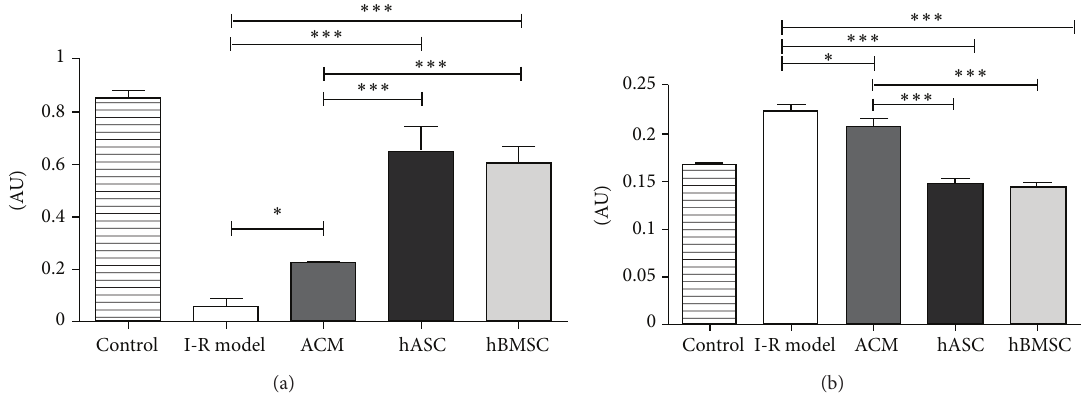
Figure 4: Metabolic activity measurement and LDH assay. (a) The metabolic activity measured 24 hours after the ischemia-reperfusion injury significantly decreased in the cells after the ischemic conditions compared to the control group, but the metabolic activity was enhanced with all the applied treatments (control: 0.858±0.021 AU; I-R model: 0.065±0.033 AU; ACM: 0.225±0.013 AU; hASC: 0.652±0.089 AU; hBMSC: 0.607±0.059 AU; 𝑛 = 3 , ∗ 𝑃 < 0.05 , ∗∗∗ 𝑃 < 0.001 ). (b) LDH levels in the cell culture supernatant were significantly lower when ACM, hASC, or hBMSC therapy was carried out (I-R model: 0.225±0.006 AU; ACM: 0.208±0.009 AU; hASC: 0.148±0.005 AU; hBMSC: 0.146±0.004 AU; 𝑛 = 3 , ∗ 𝑃 < 0.05 , ∗∗∗ 𝑃 < 0.001 ). The stem cell treated groups are not significantly different from each other and also not different from the